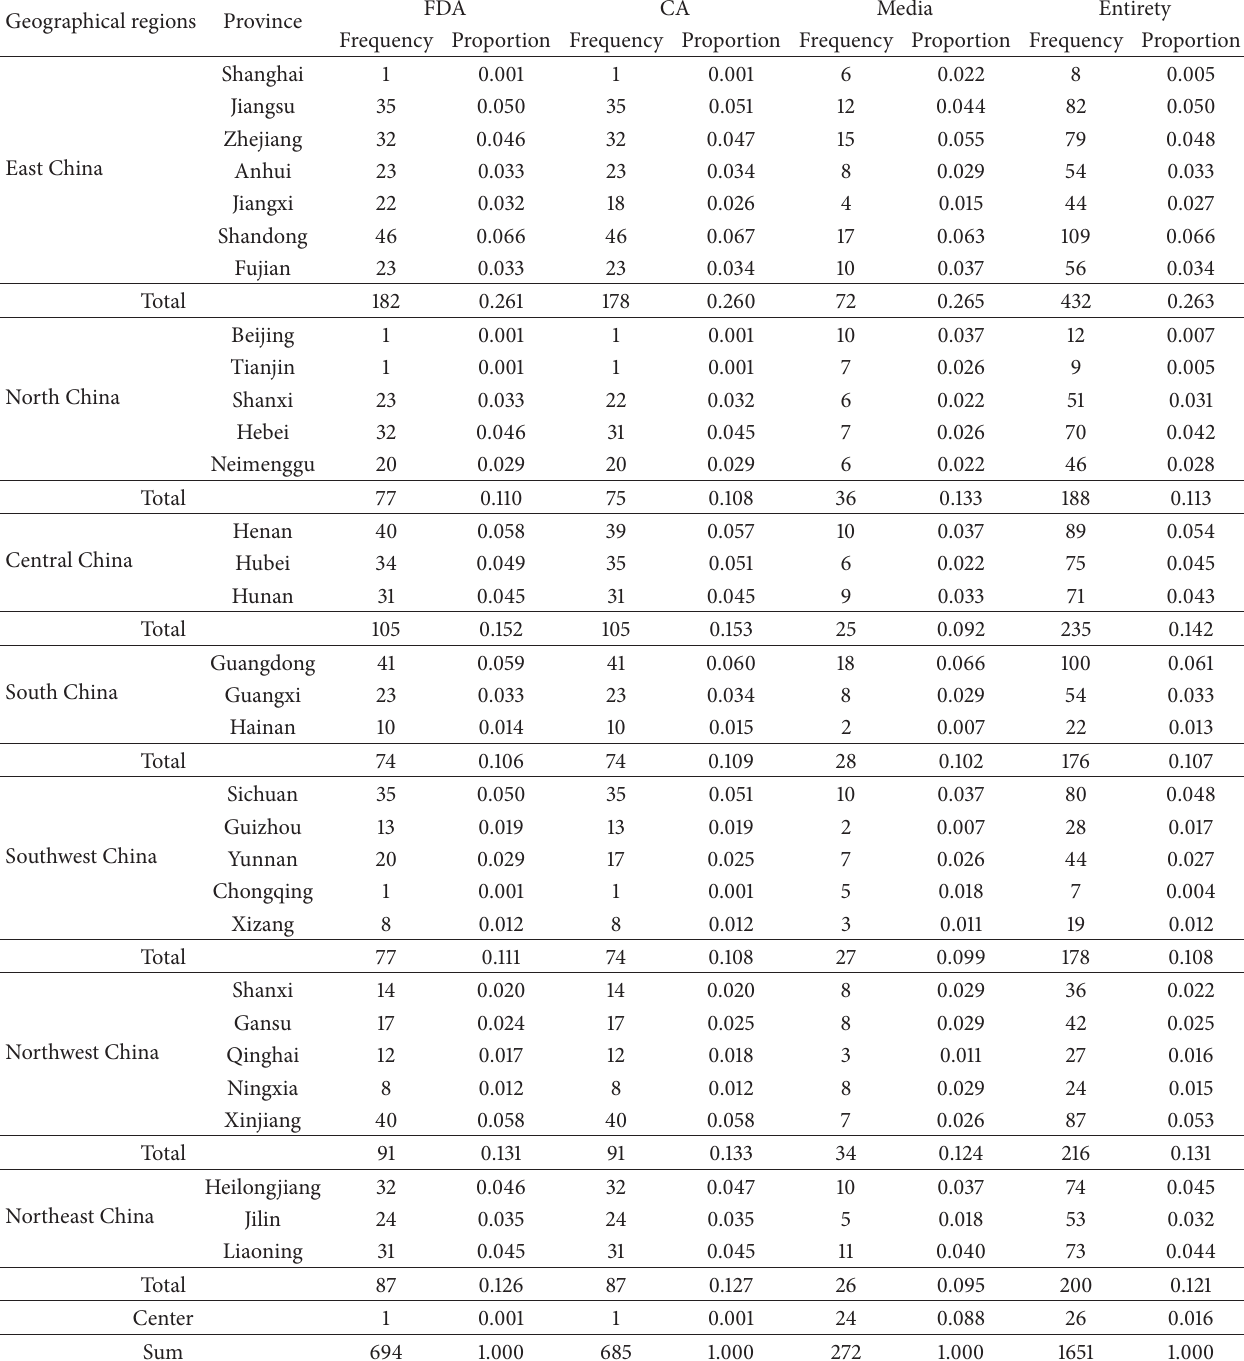
Table 5: Characteristics of different geographical